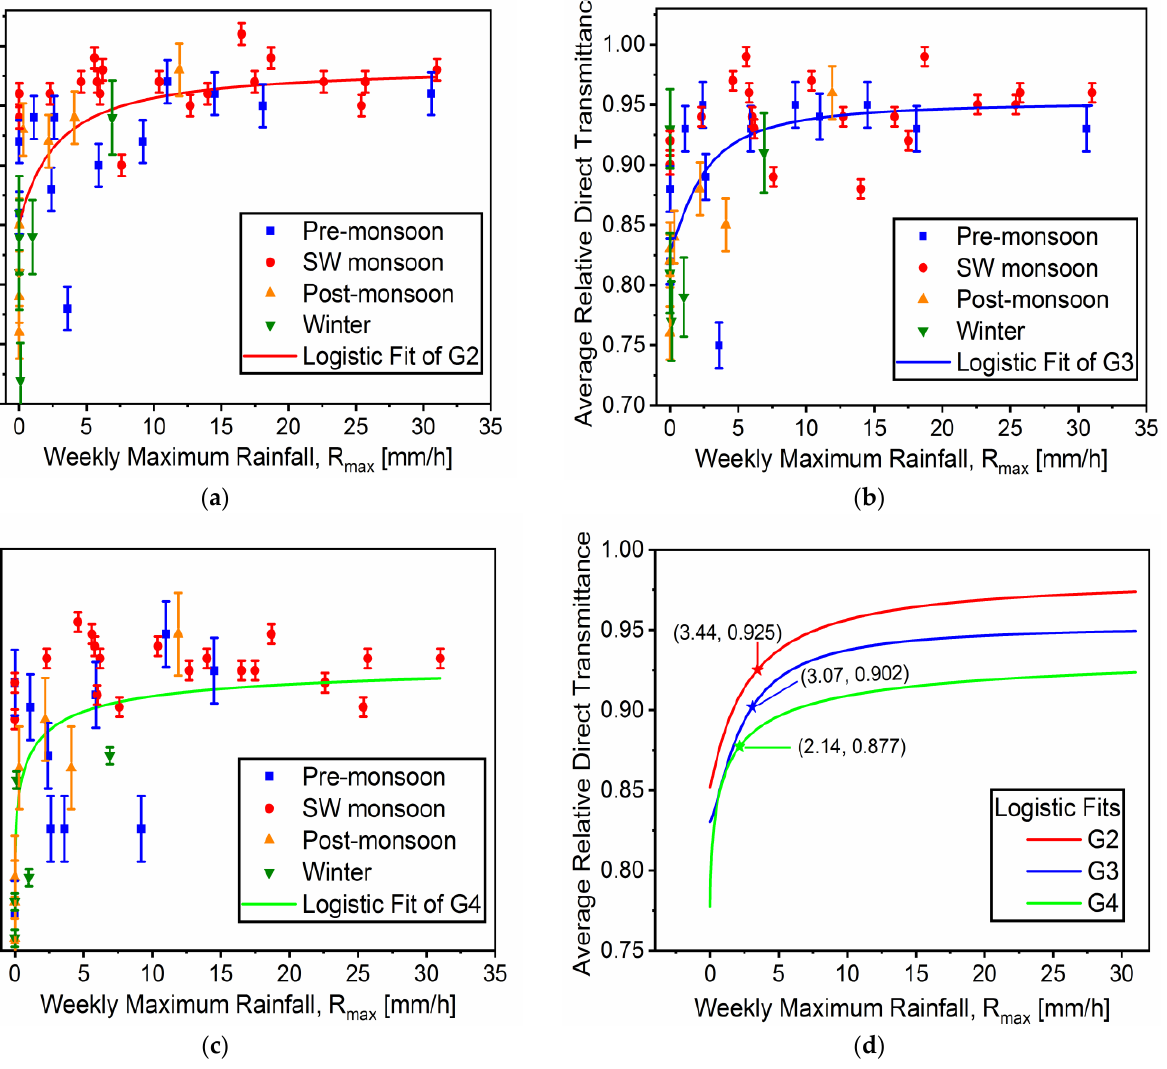
Figure 8. The average relative direct transmittance versus the weekly maximum rainfall ( R max ) for the ( a ) weekly cleaned glass (G2), R 2 = 0.42; ( b ) monthly cleaned glass (G3), R 2 = 0.40; ( c ) never cleaned glass (G4), R 2 = 0.39; and ( d ) the threshold rainfall required to clean the glass coupon under various cleaning schedule. (The values of the parameters are provided in Table S3.)